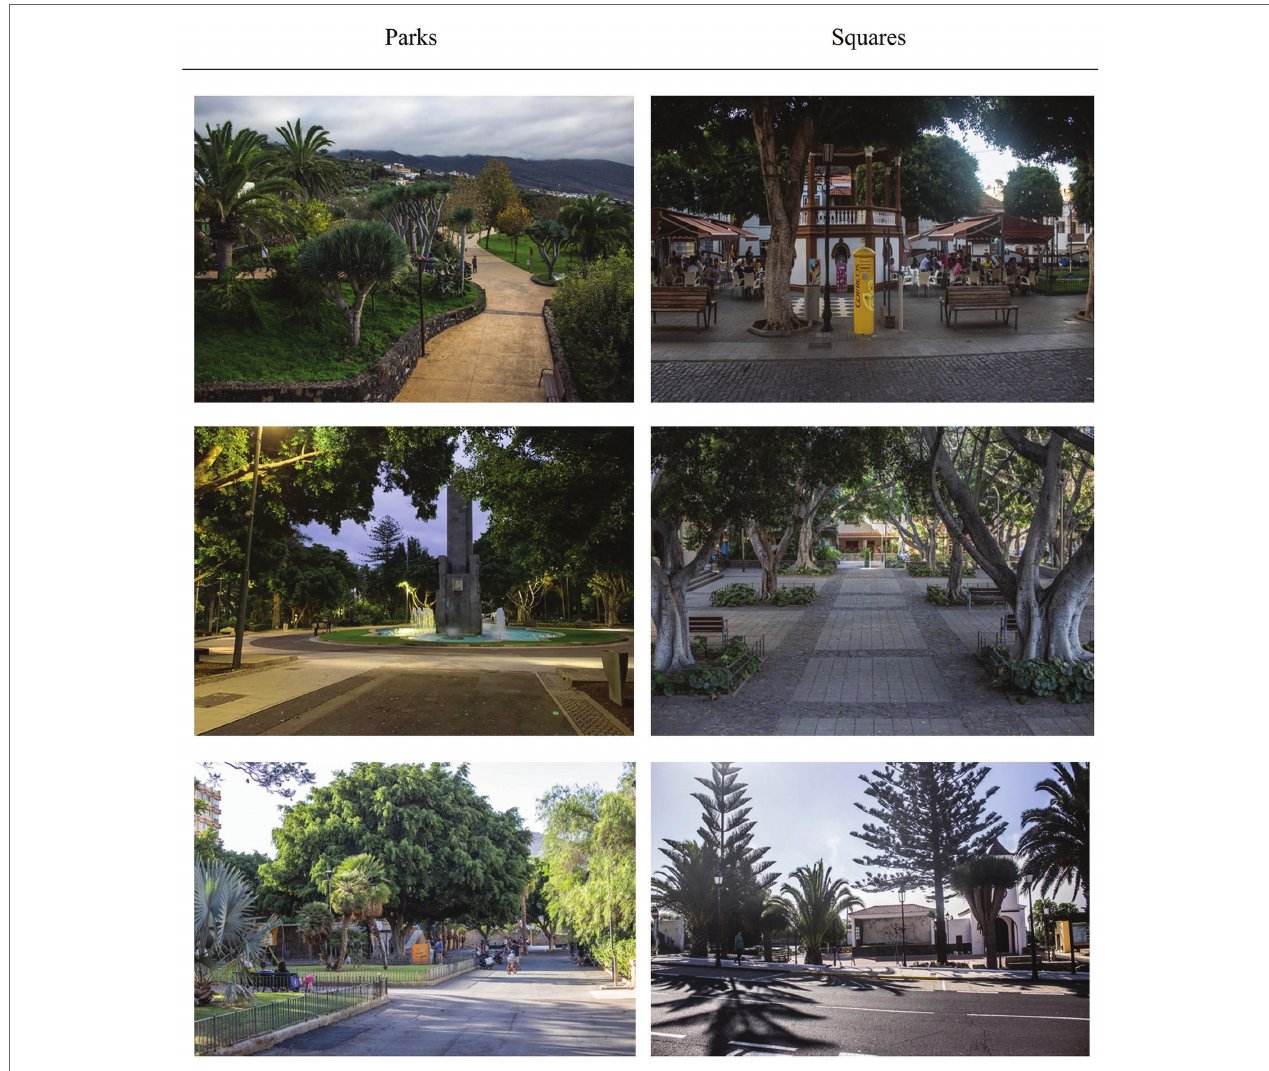
FIGURE 1 | Photographs of parks and